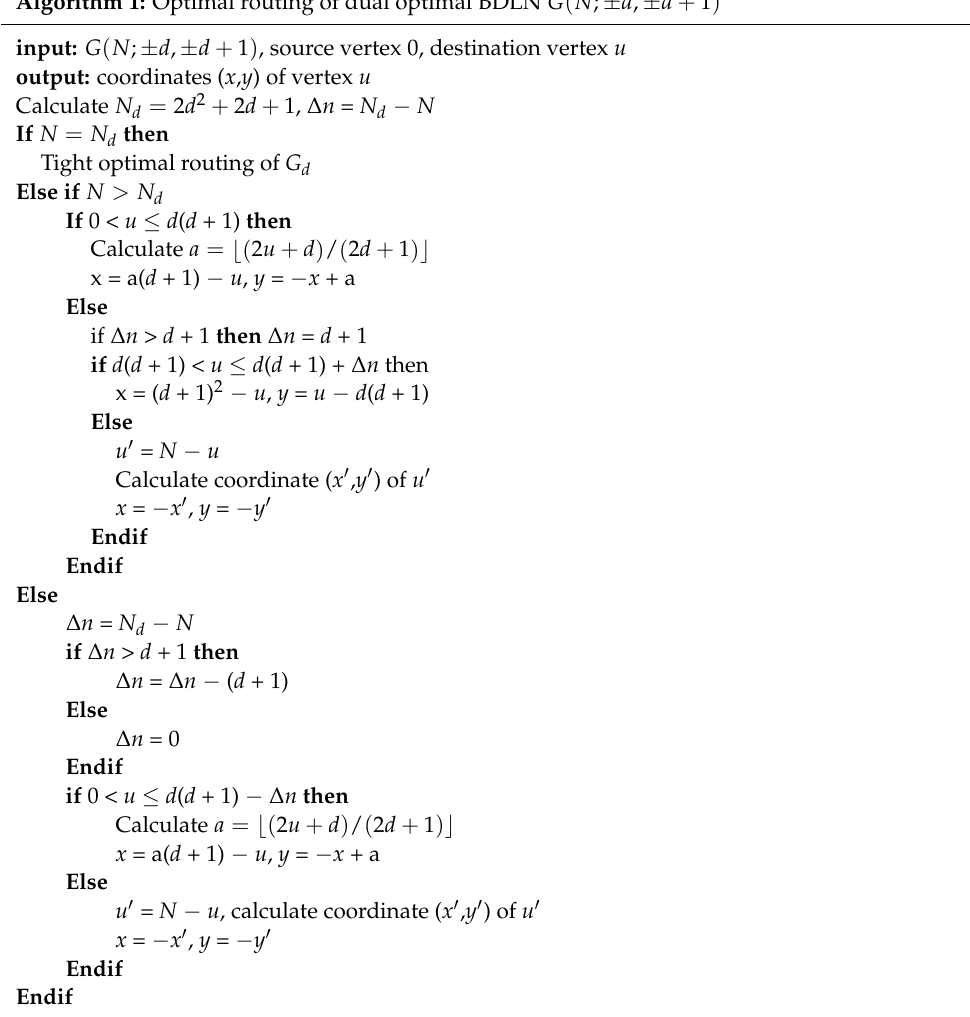
Algorithm 1: Optimal routing of dual optimal BDLN G ( N ; ± d , ± d + 1